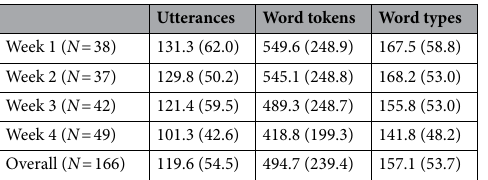
Table 2. Mean (SD) number of parent utterances, word tokens, and word types in the picture-book interaction, overall and separately by visit week.